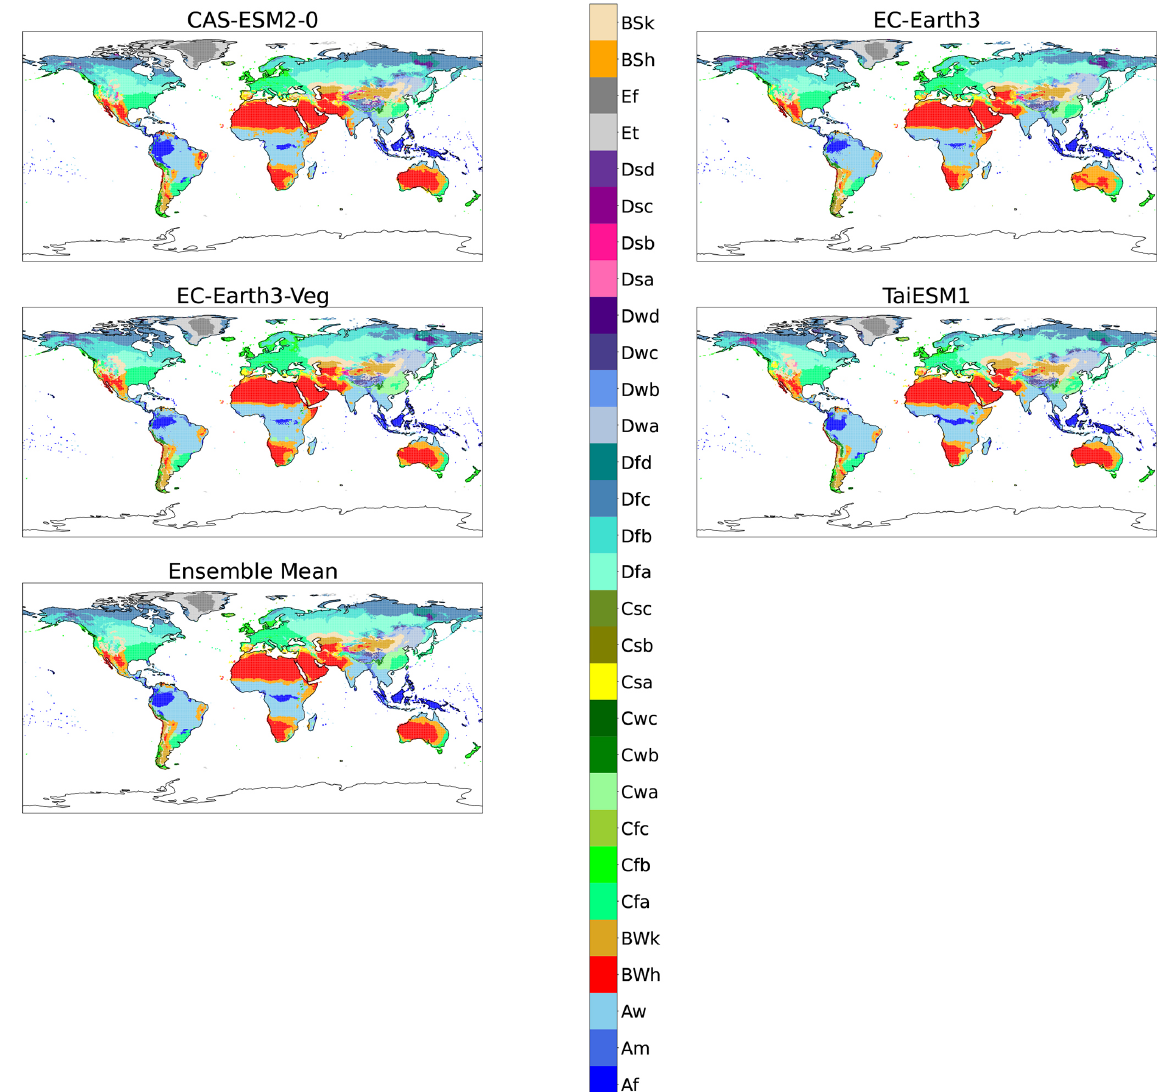
Figure A6. Maps of KG classifications for each model at + 4K with anomaly